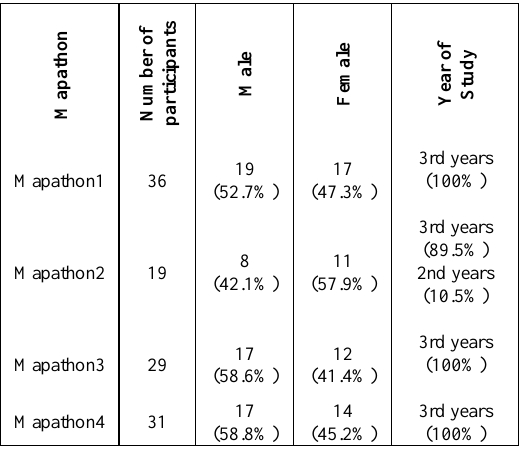
Table 4. Participants of the four